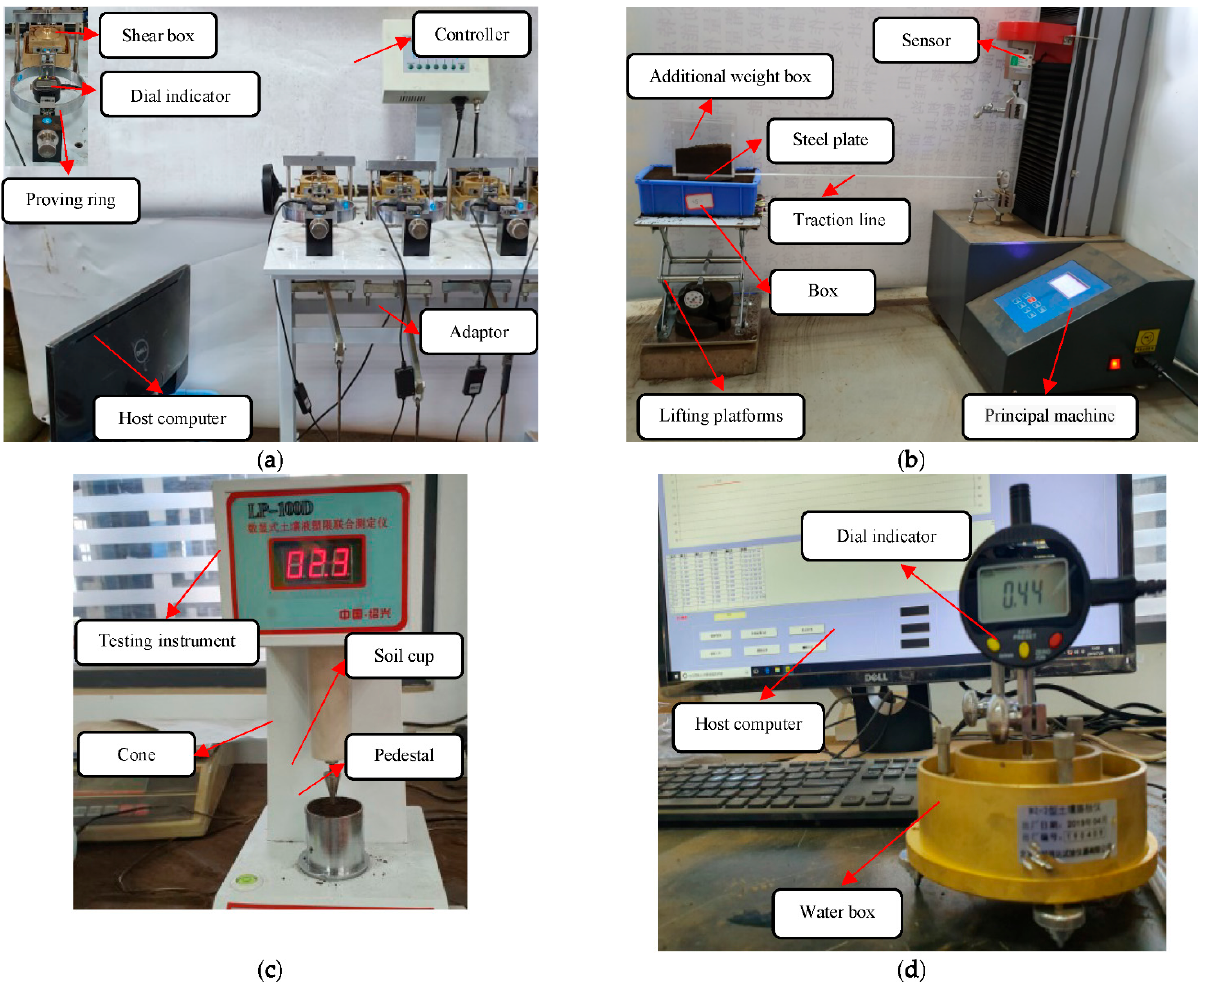
Figure 2. Test instruments: ( a ) ZJ-4L strain-controlled direct shear apparatus, ( b ) soil adhesion test bench, ( c ) LP-100D digital display soil liquid-plastic limit determinator, and ( d ) WZ-2 soil dilatometer.